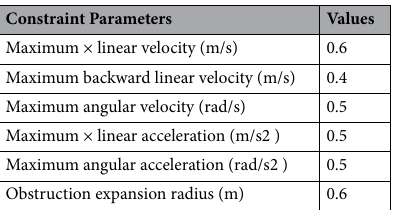
Table 4. Parameter configurations of the simulated